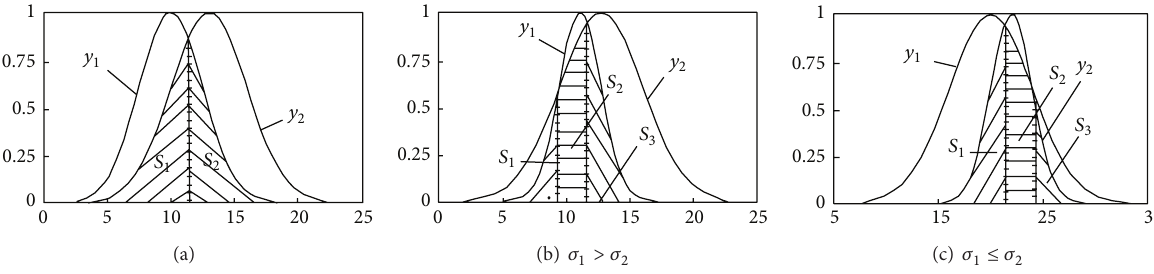
Figure 3: Similar situation between normal